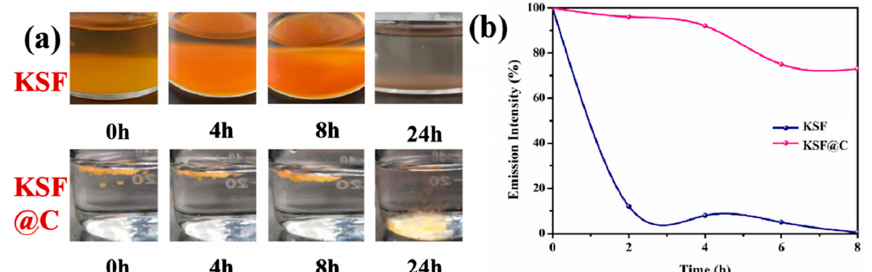
Figure 11. ( a ) The photographs of K 2 SiF 6 : Mn 4+ and K 2 SiF 6 : Mn 4+ @C after immersion for different times; ( b ) emission intensity curves of K 2 SiF 6 : Mn 4+ and K 2 SiF 6 : Mn 4+ @C phosphors after hydrolysis for different times. (Reprinted from Ref [48]. Copyright from Elsevier, 2020).